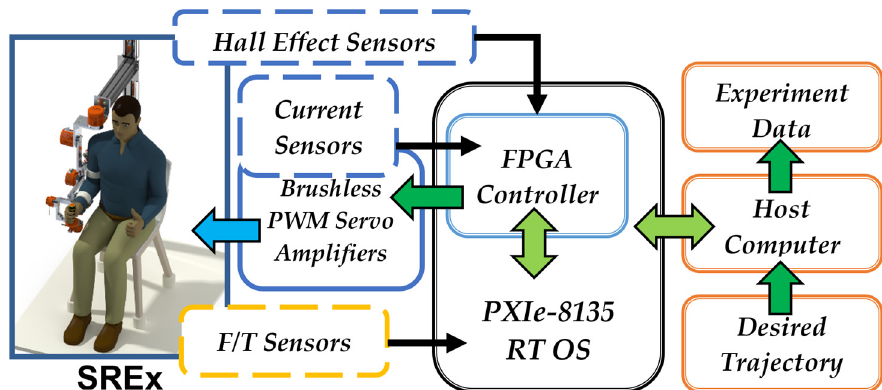
Figure 4. Experimental setup with SREx system.